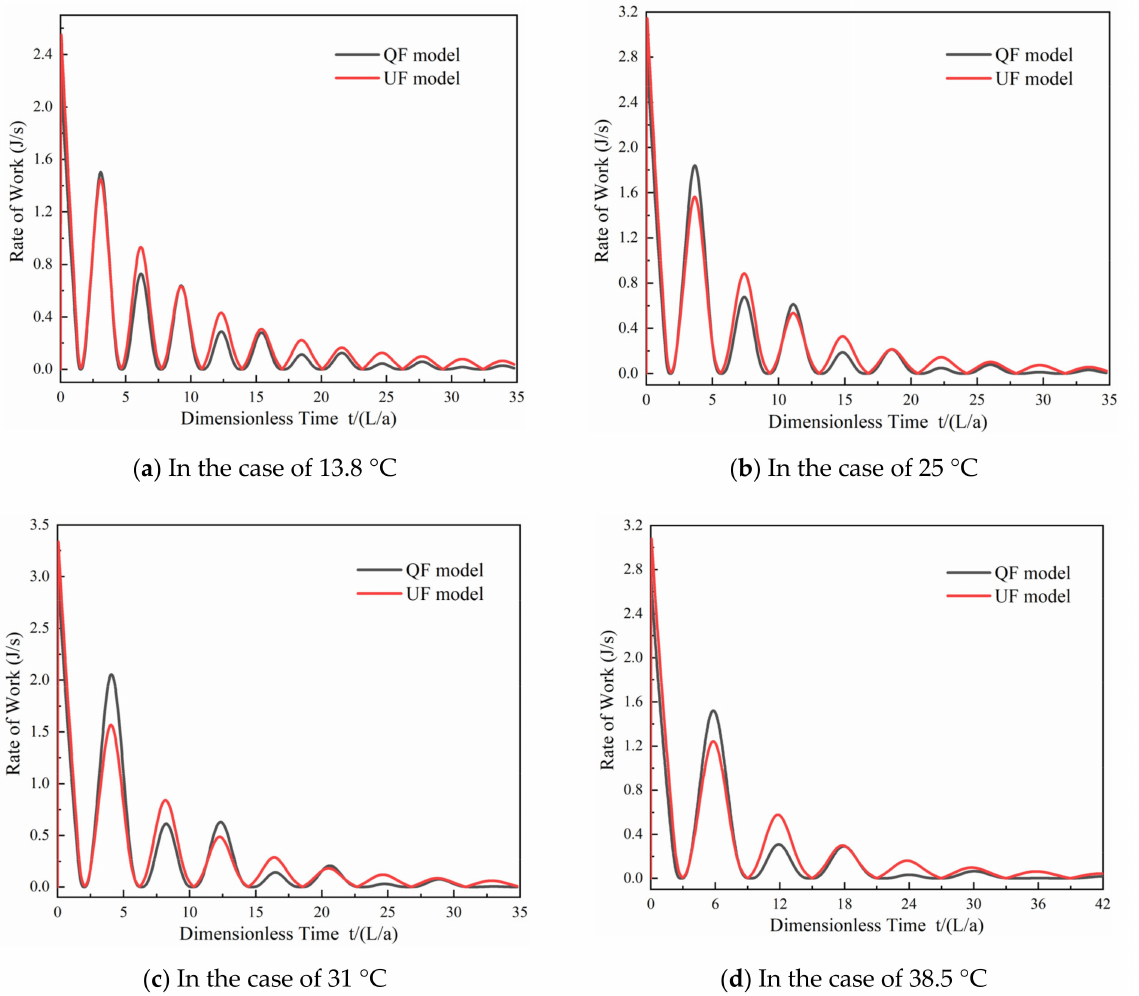
Figure 10. Comparison of the dissipation rates of the QF and UF models: ( a ) 13.8 ◦ C; ( b ) 25 ◦ C; ( c ) 31 ◦ C; ( d ) 38.5 ◦